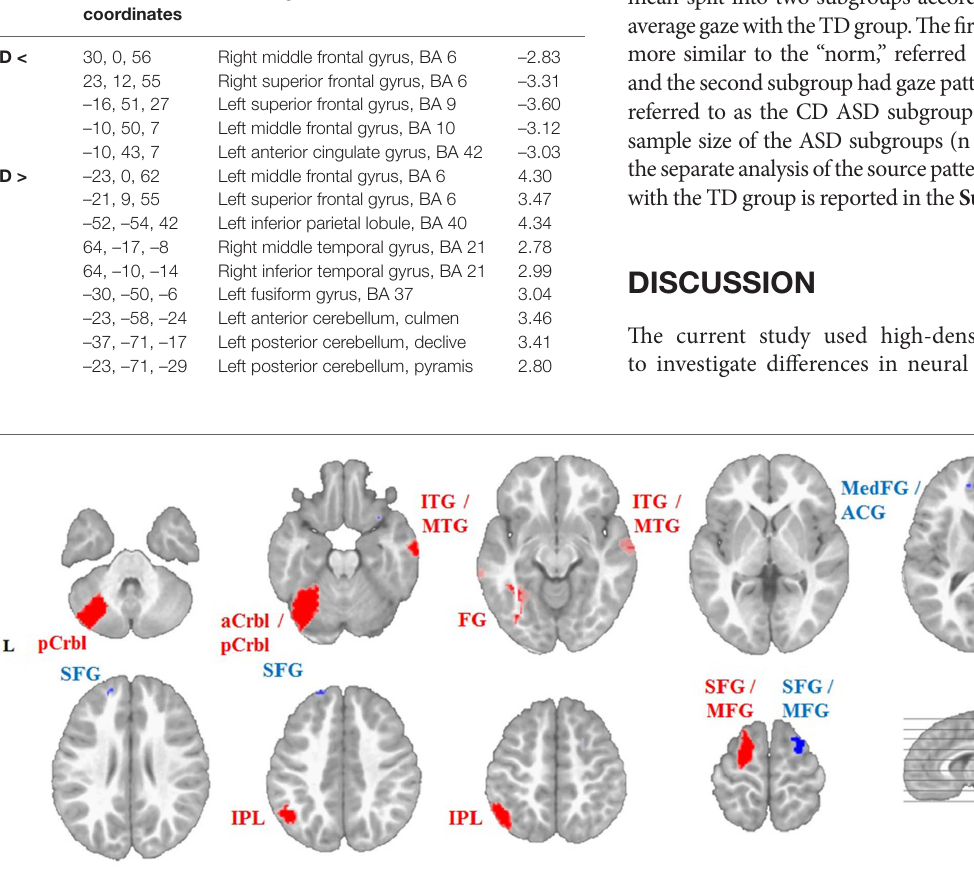
FIGURE 5 | Source localization of group differences for Group Map 4 showing decreased activation of the left medial frontal gyrus (MedFG)/anterior cingulate gyrus (ACG) complex, left and right superior frontal gyrus (SFG), and right middle frontal gyrus (MFG), and increased activation of the left anterior (aCrbl) and posterior cerebellum (pCrbl), left fusiform gyrus (FG), right inferior and middle temporal gyri (ITG/MTG), left inferior parietal lobule (IPL), and left SFG/MFG gyri in the autism spectrum disorder (ASD) group (n = 14) compared to the typically developing (TD) group (n = 14) during free viewing of “Trotro” cartoons. The t-values of the unpaired t-test thresholded to P < 0.01 of the randomization test are plotted. L, left; R,